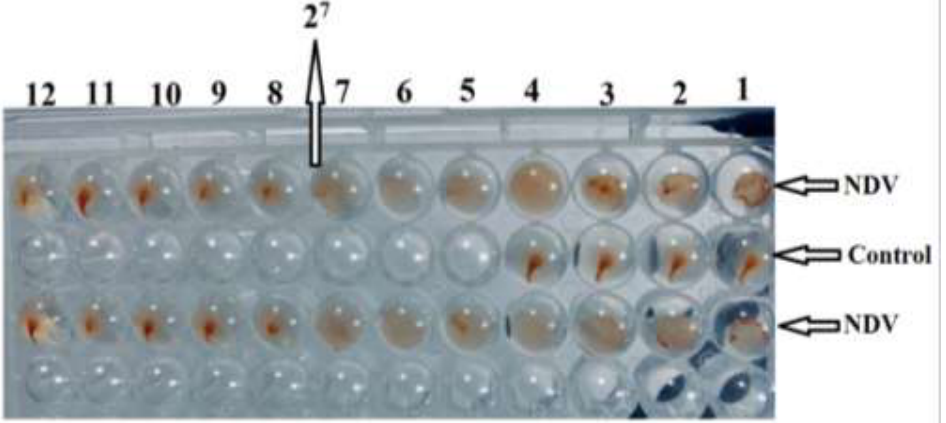
Figure 4: The HA test displays both agglutinated and non-agglutinated RBCs in a part of the 96-well plate. It's worth noting that the reading was performed twice. Erythrocyte agglutination results at the bottom of a distinct lattice, whereas negatory hemagglutination is distinguished with an acute